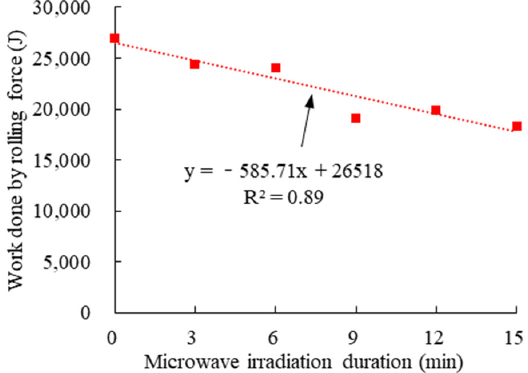
Figure 14. Relationship between the work done by the rolling force and the microwave exposure time.